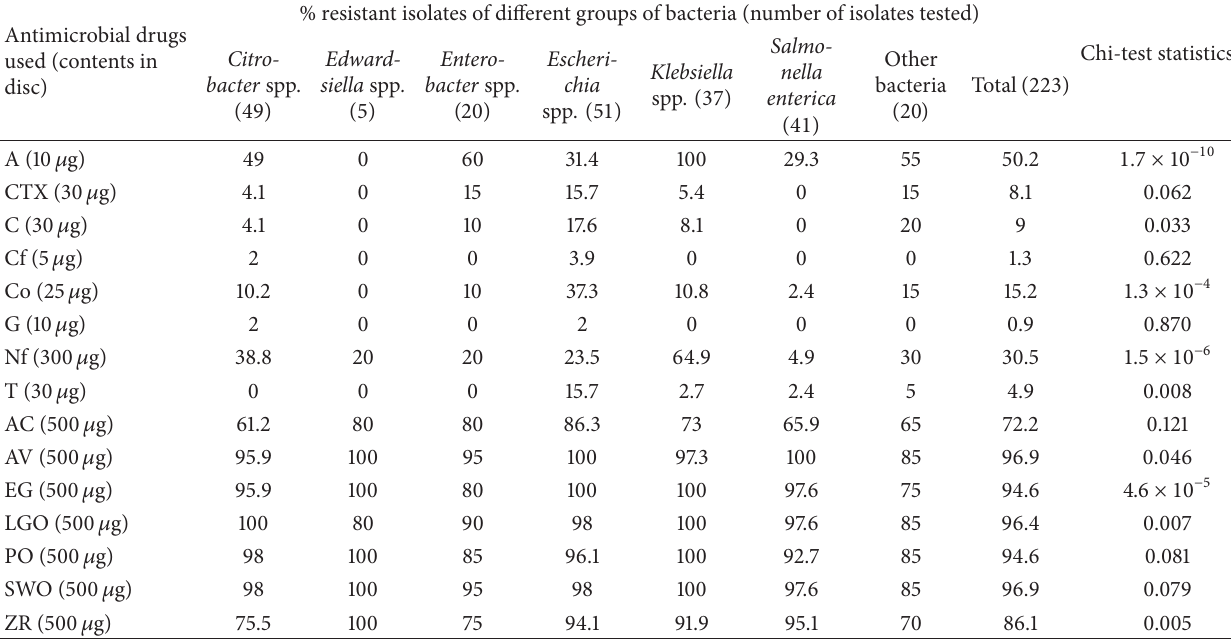
Table 5: Variation in antimicrobial drug resistance (% strains) among different groups of bacteria isolated from faecal droppings of geckos. Antimicrobial